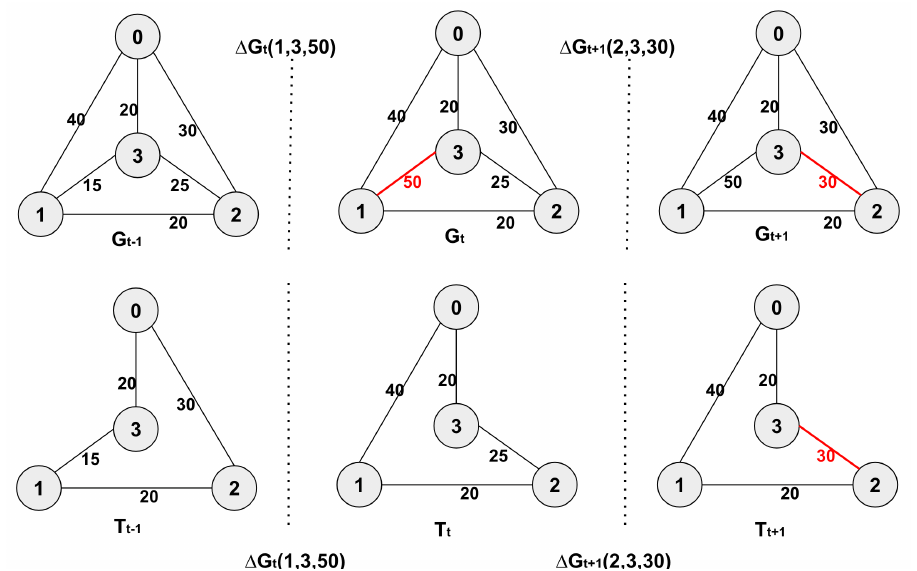
Figure 1. Top three imagesshow TEGs with various update events, and the bottom three images are their respective TSP tours.